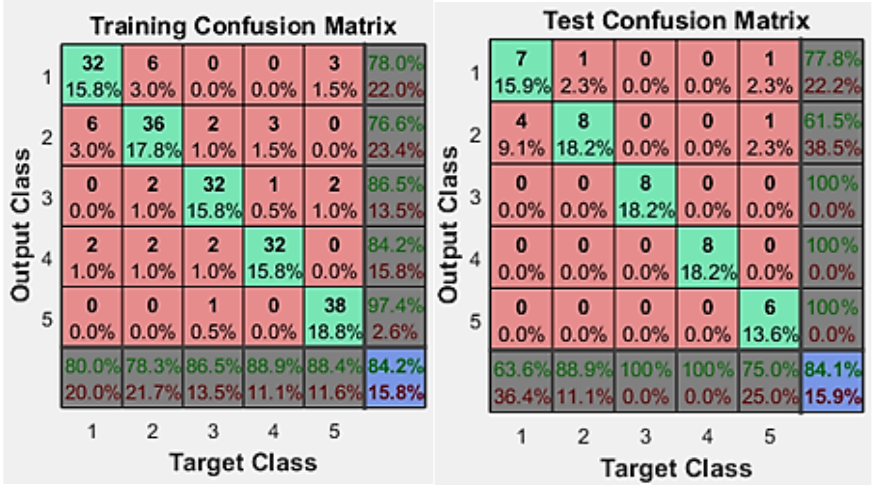
Figure 6. Confusion Matrix for Training Dataset.